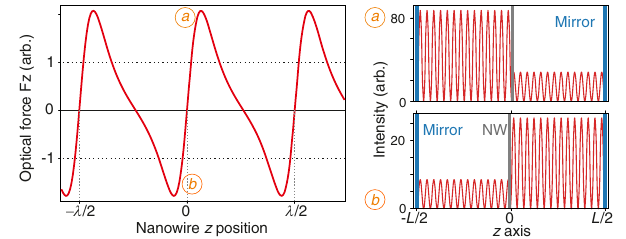
FIG. 17. Simulations of the optical axial force computed for different nanowire positions along the optical axis. The right panels illustrate the shape of the intensity distribution in the system for two positions of the oscillator, on the left and right sides of an optical node of the intracavity field. The left-right distributions of the field intensity in the two subcavities allow us to understand the repulsive character of the force profile observed in the vicinity of optical